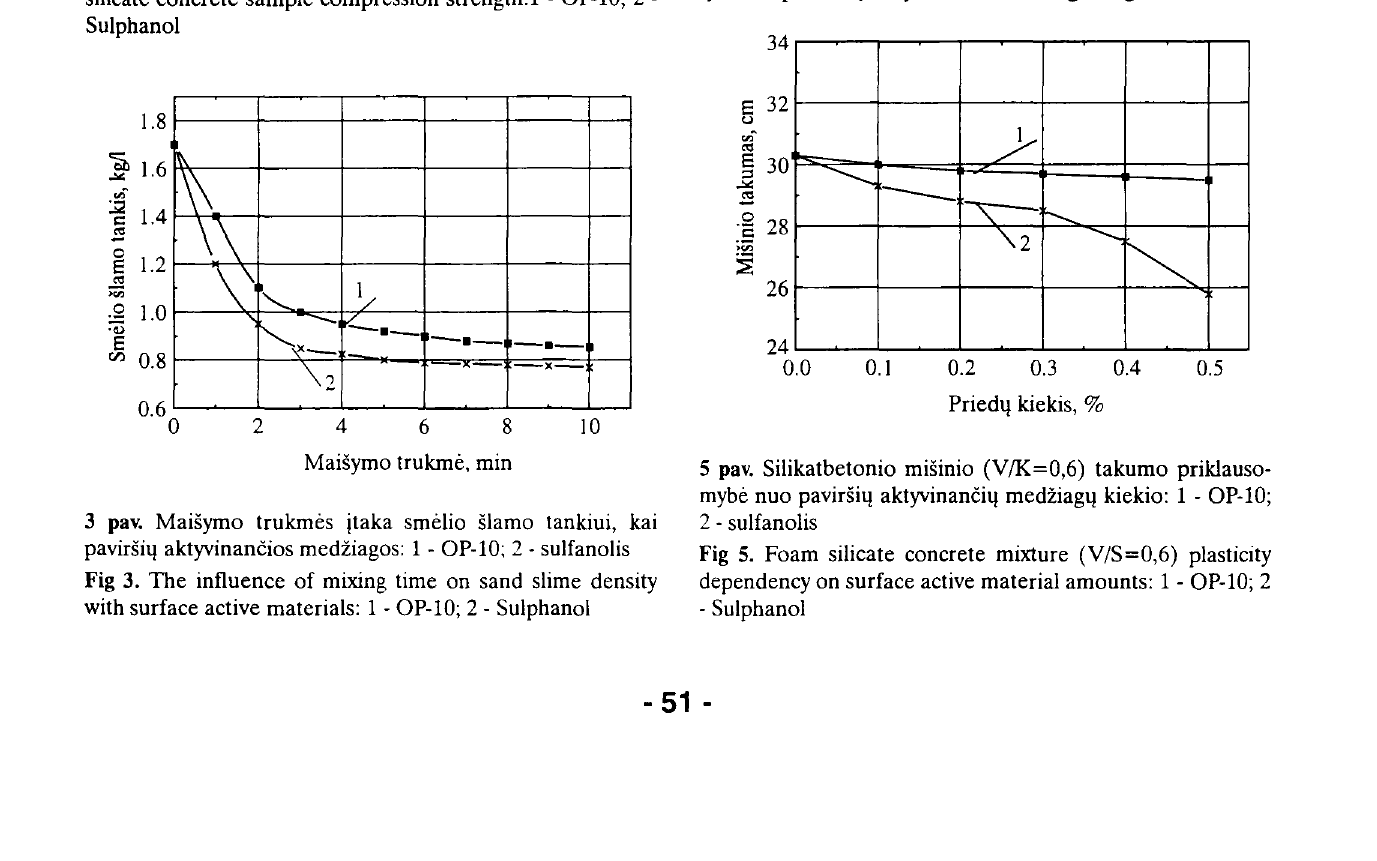
Fig 2. Surface active material amount influence on cast silicate concrete sample compression strength:! - OP-10; 2-